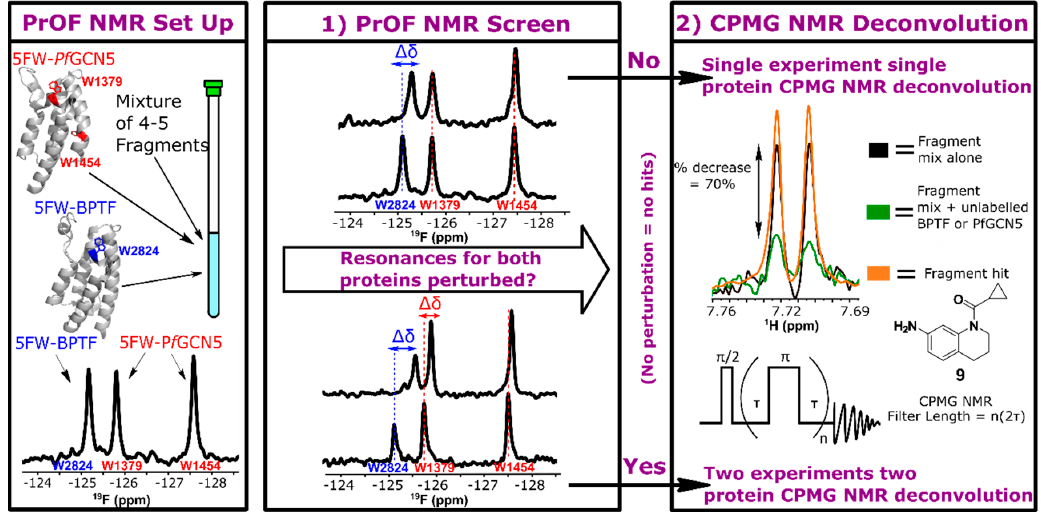
Figure 1. Screening workflow. ( Left ) The location of each 5FW resonance on the proteins and in the 19 F NMR spectra (PDB ID = 4QNS, 3UVW). ( Middle ) Representative binding experiments in which case one or both proteins resonances are a ff ected. ( Right ) A representative 1 H CPMG NMR experiment in which case a decrease in resonance intensity is observed in the ligand + protein vs the ligand alone spectra. To deconvolute the 1 H CPMG NMR mixture binding experiments, the 1 H NMR spectra of each individual ligand in that mixture are overlaid to identify the corresponding ligand